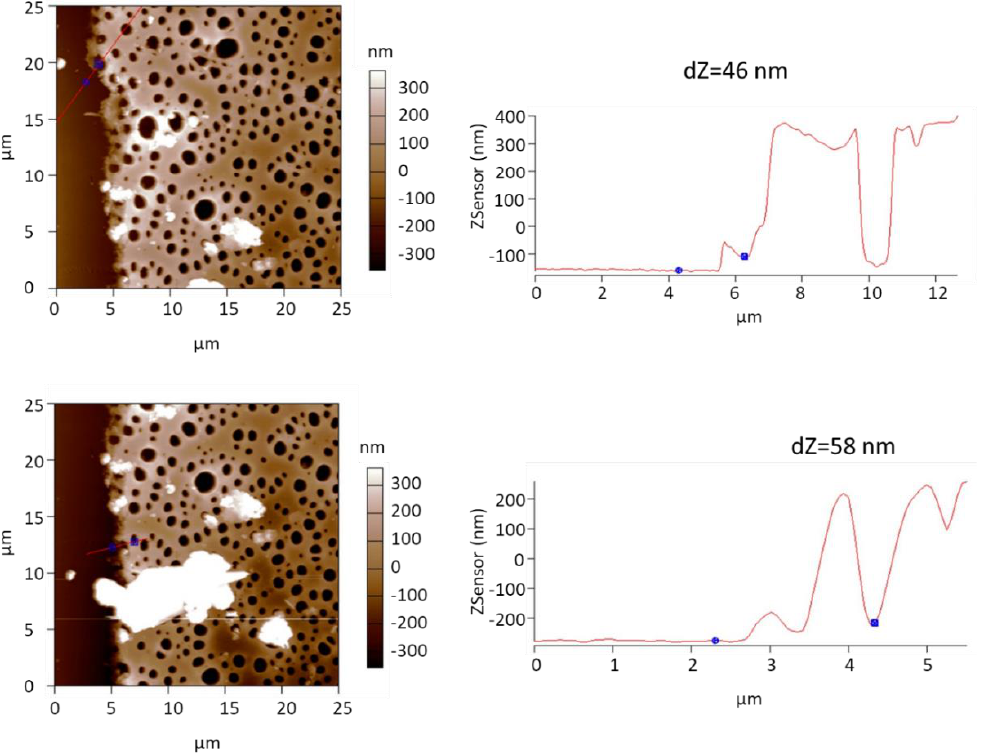
Figure 3. Left : Two representative atomic force microscopy (AFM) images of the SURGEL / por-PMMA membranes on top of the PAN / PDMS support. Right : Corresponding height profile along the red lines of the two images. The di ff erence in height from the PDMS support to the SURGEL layer is given as dZ value above the height profiles.